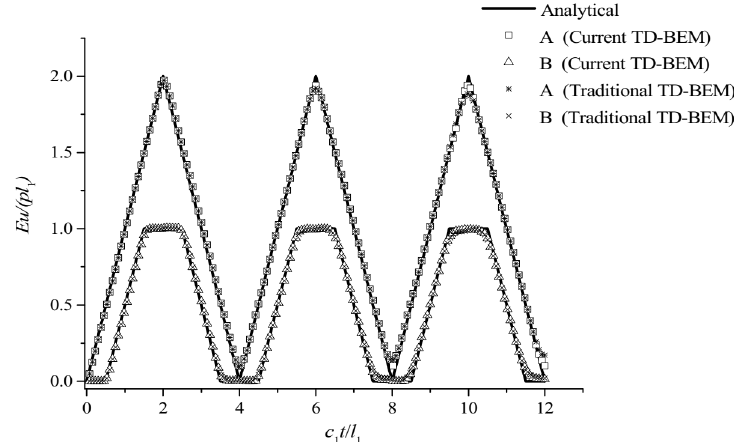
Figure 8. Comparison between the results of displacement from current 3D TD-BEM, traditional 3D TD-BEM, and the analytical solutions.